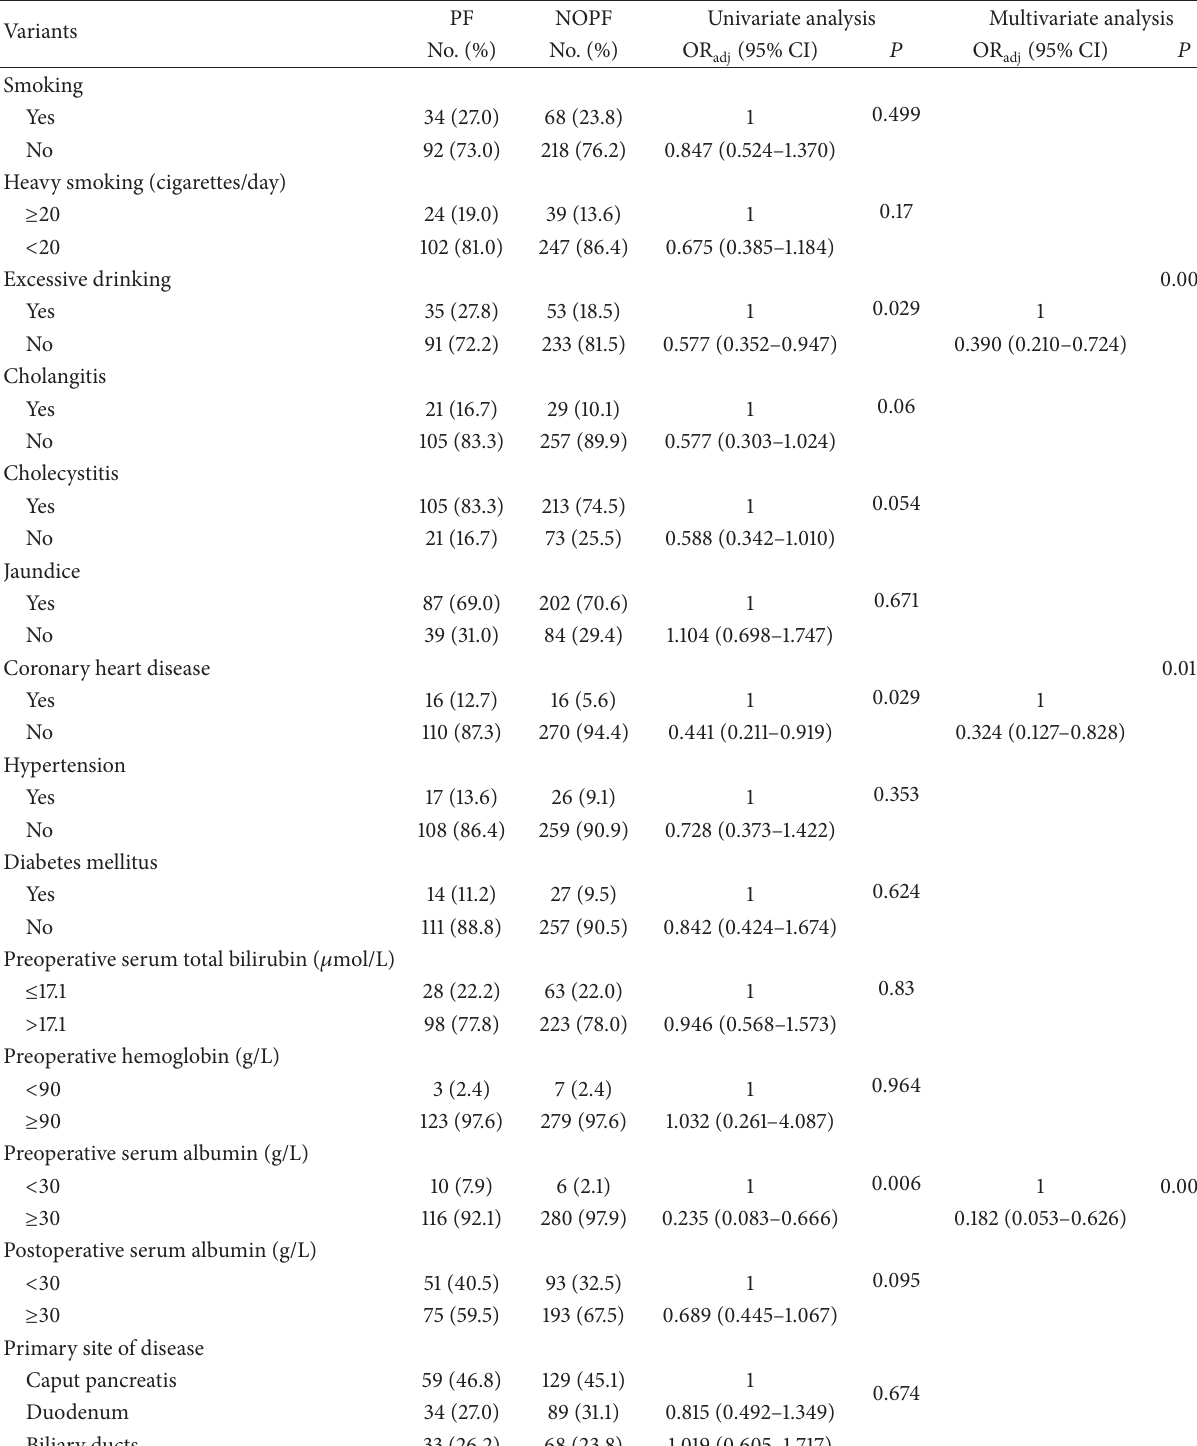
Table 2: Analysis for potential-related risk of pancreaticocutaneous fistula (PF) factors (univariate and multivariate analysis). (a) Patient-related factors for